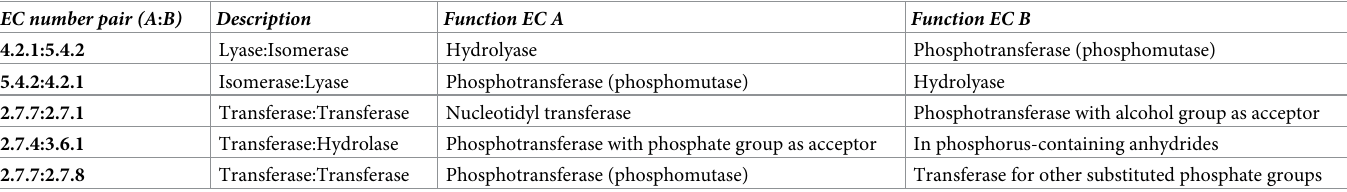
Table 2. EC pairs universally distributed. In the fourth column is the frequency of each protein domain, identified by Superfamily searches. EC number pair (A :